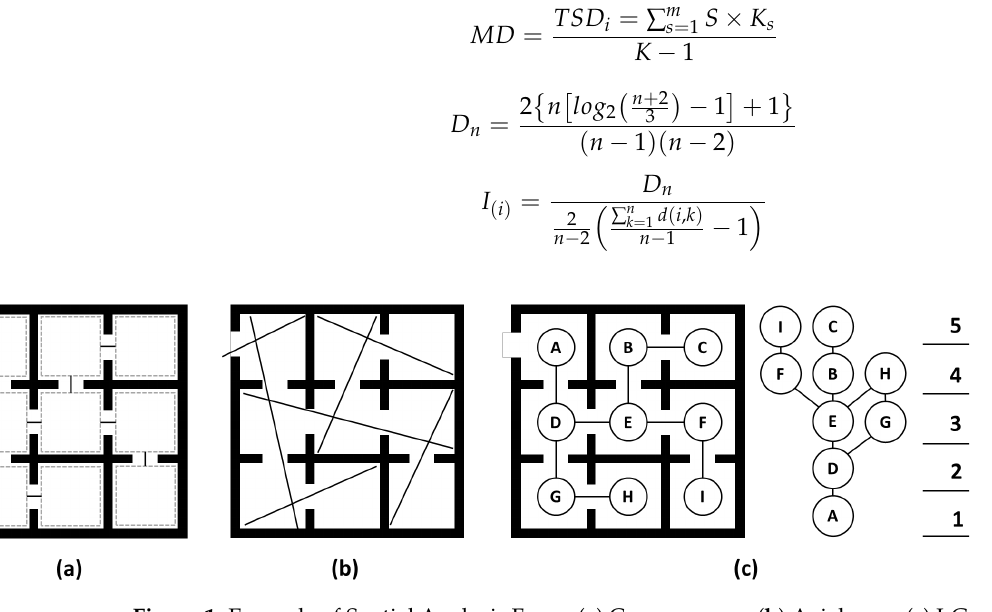
Figure 1. Example of Spatial Analysis Form: ( a ) Convex space; ( b ) Axial map; ( c ) J-Graph.